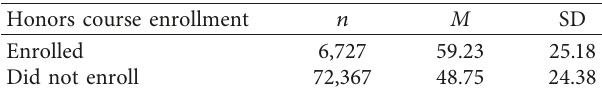
Table 2: Descriptive statistics for student effort benchmark scores by honors course enrollment